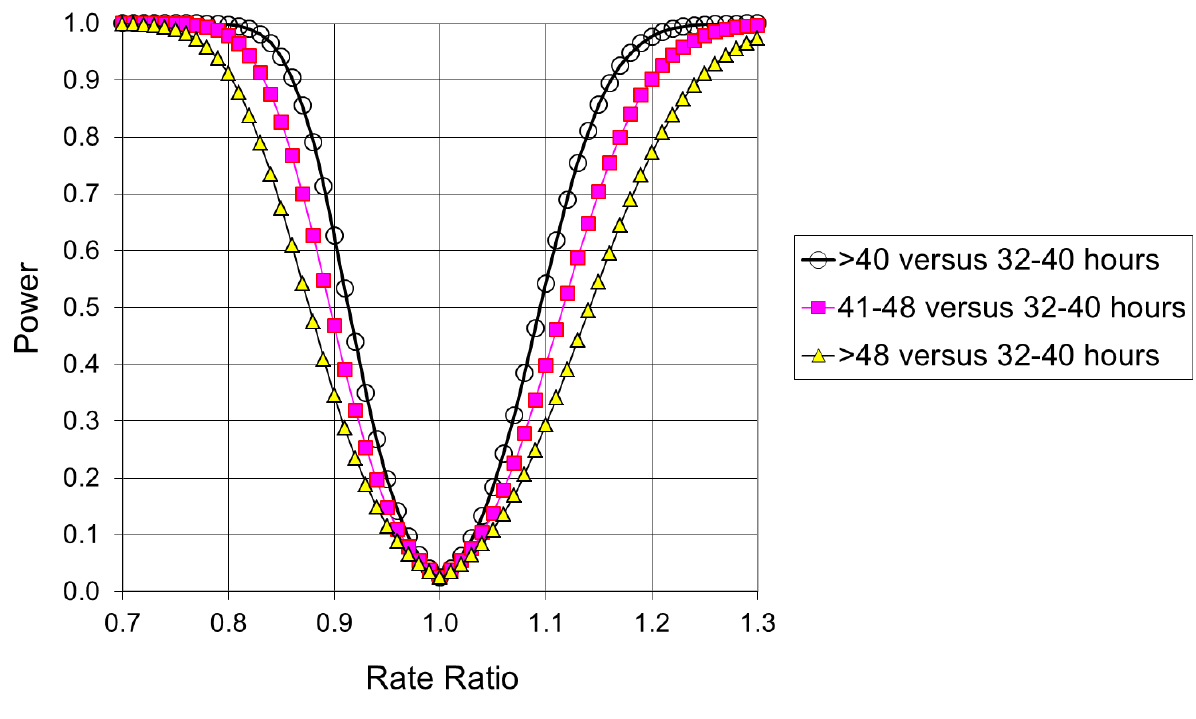
Figure 1. Power of detecting differences in psychiatric morbidity rates in Denmark, between overtime workers and people with normal work hours, as a function of the true rate